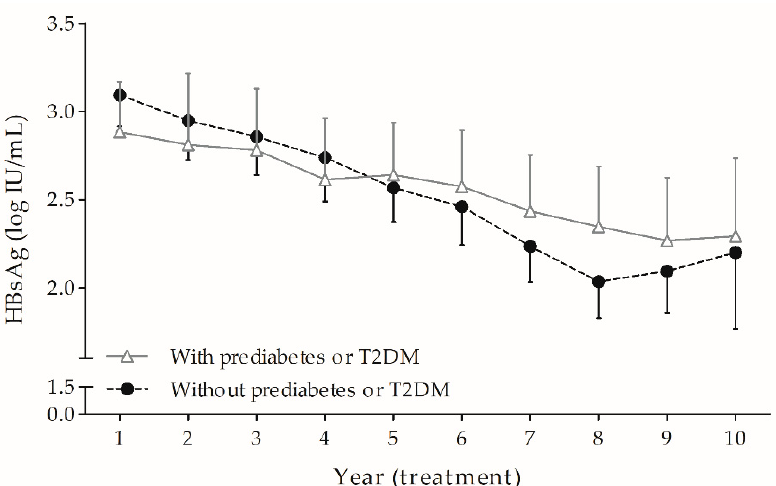
Figure 2. HBsAg kinetics during entecavir treatment over time, categorized by with or without prediabetes or T2DM. The serum HBsAg levels were derived from a linear mixed e ff ects model, with adjusted mean and 95% confidence intervals (error bars). HBsAg, hepatitis B surface antigen; T2DM, type 2 diabetes mellitus. Table 2. Multivariate linear mixed e ff ects models for predicting HBsAg during the 2nd to 10th years, including the 14 baseline variables and three significant interaction terms (age and time, prediabetes or type 2 diabetes mellitus (T2DM) and time, as well as advanced fatty liver and time). Multivariate Analysis (the General Model Components